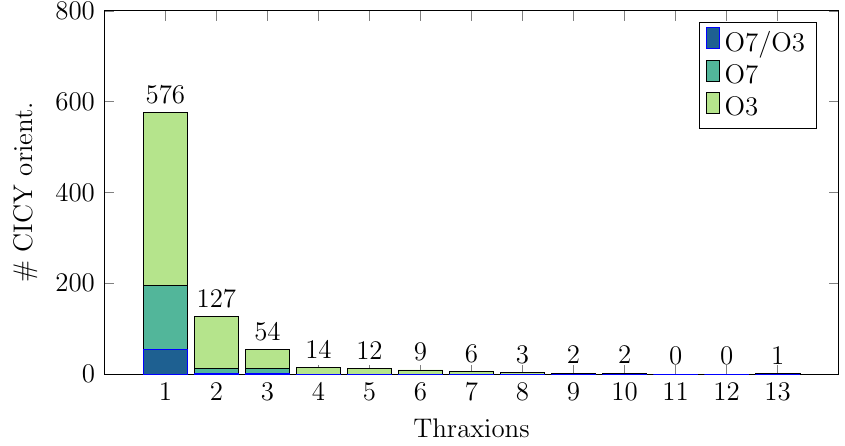
Figure 4 . Number of CICY orientifolds in M 2 for given number of thraxions. The different colors show the presence of both O7/O3-planes, or only O7 or O3-planes. The detailed numbers of CICY divided by the kind of the orientifolds and the number of thraxions are shown in table 3.